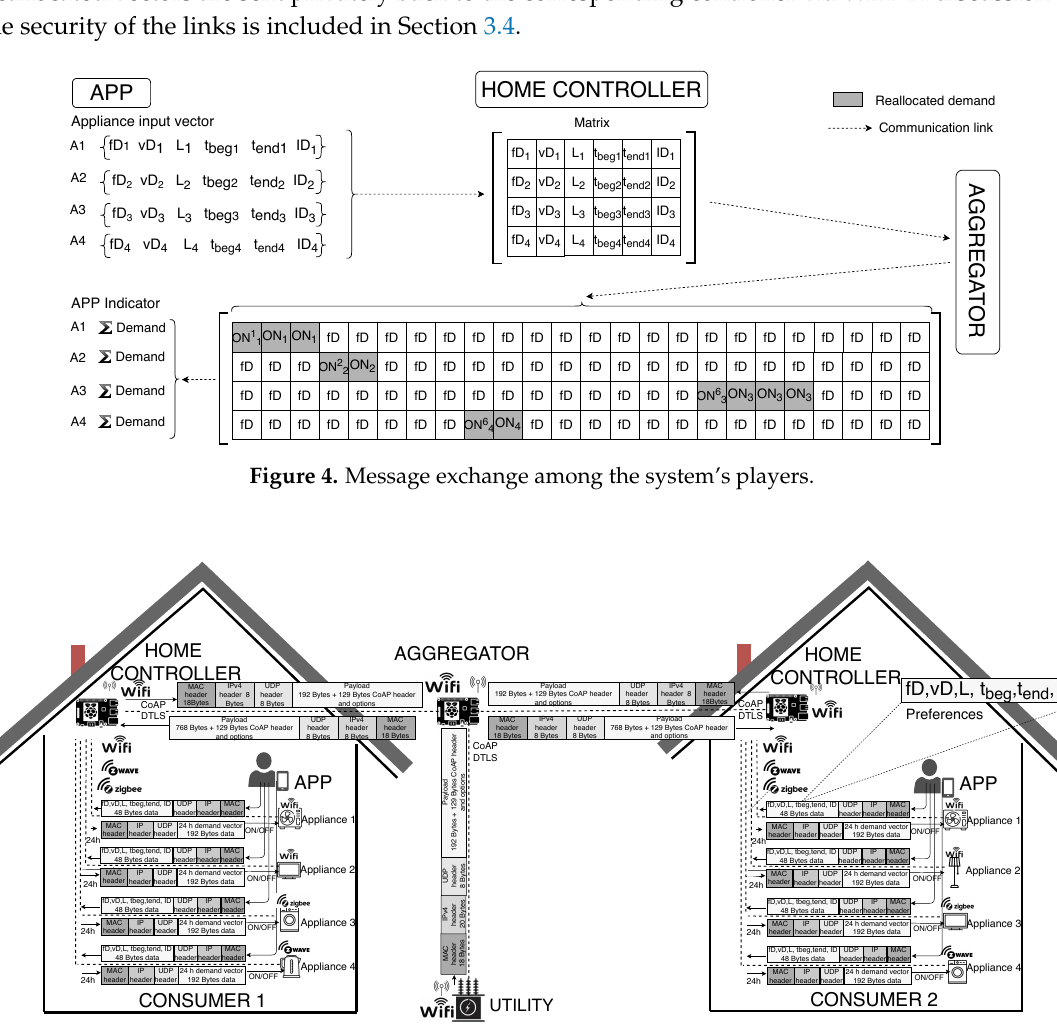
Figure 5. Message specification between app-home controller, home controller- aggregator , and